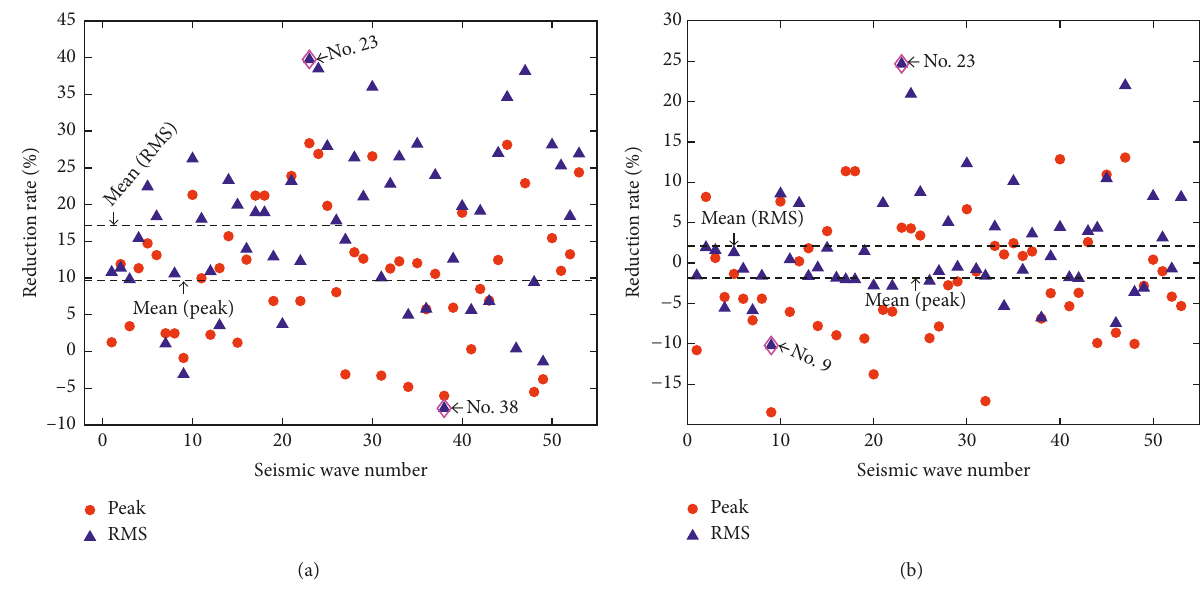
Figure 19: Reduction rates under 53 sets of seismic excitations. Reduction rates of (a) displacement and (b)